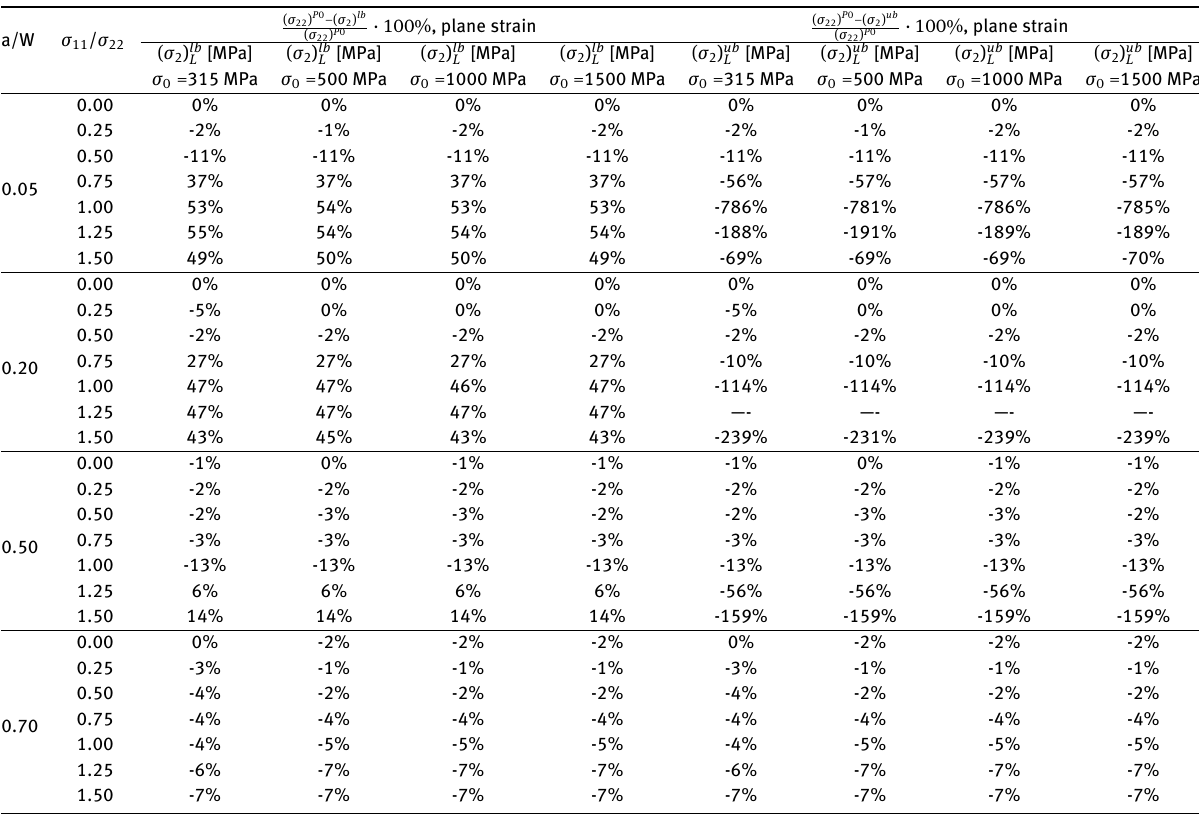
Table 7: Percentage differences between the numerical values of the limit loads determined for the plane strain state ( σ 22 ) P 0 and the values calculate from formulae (2) and (3)